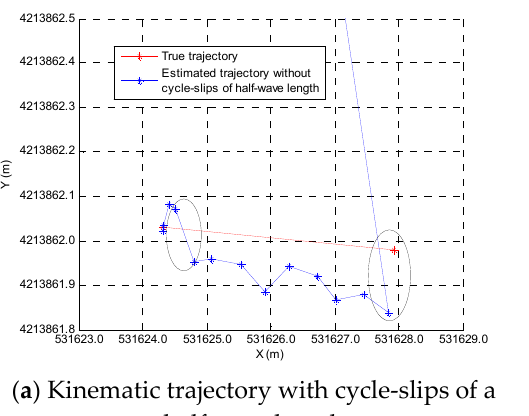
Figure 19. Kinematic trajectory with and without cycle-slips of a half-wavelength.